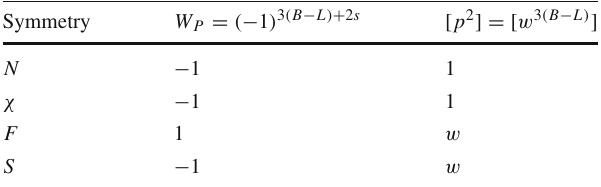
Table 3 Dark field representation under the complete residual gauge symmetry, the matter parity generated by W P and the quotient Z 3 group generated by [ p 2 ]